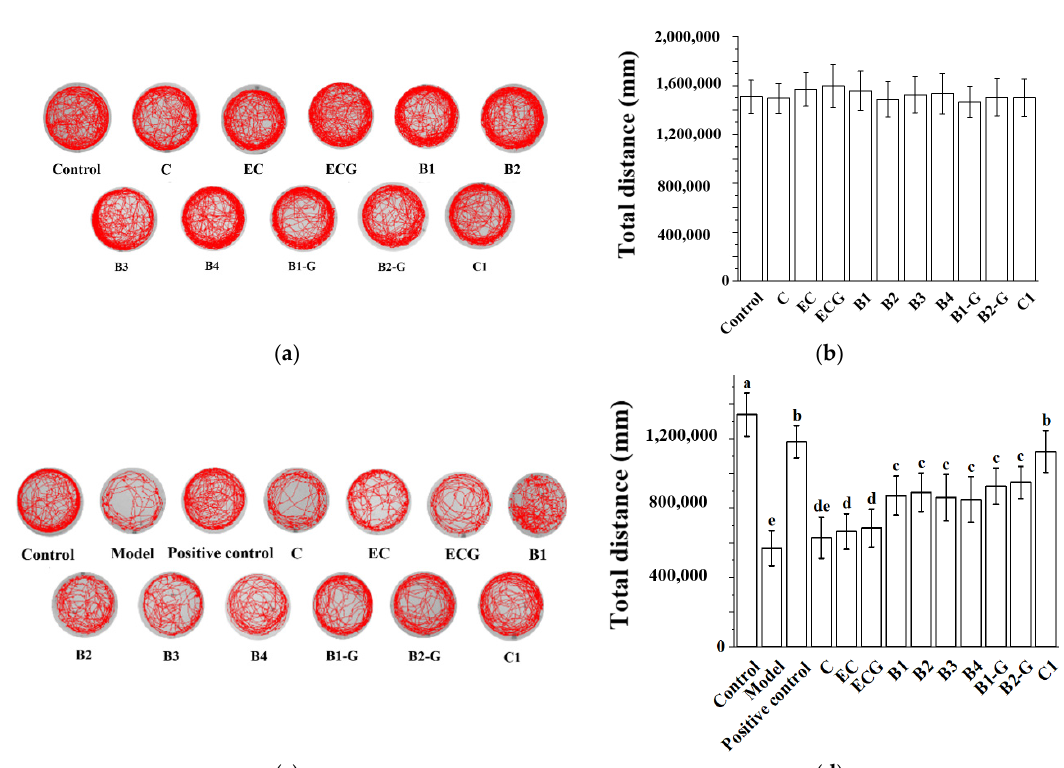
Figure 6. Effects of procyanidins with different structures on exercise ability in zebrafish treated with H 2 O 2 . ( a ) Swimming traces of zebrafish in each group; ( b ) Average total distance of zebrafish in each group; ( c ) Swimming traces of zebrafish in each group; ( d ) Average total distance of zebrafish in each group. Data are expressed as the mean ± SD. Control, Blank control group; Model, H 2 O 2 (300 μ M); Positive control, NAC (30 μ M) + H 2 O 2 (300 μ M); C, C (25 μ M) + H 2 O 2 (300 μ M); EC,